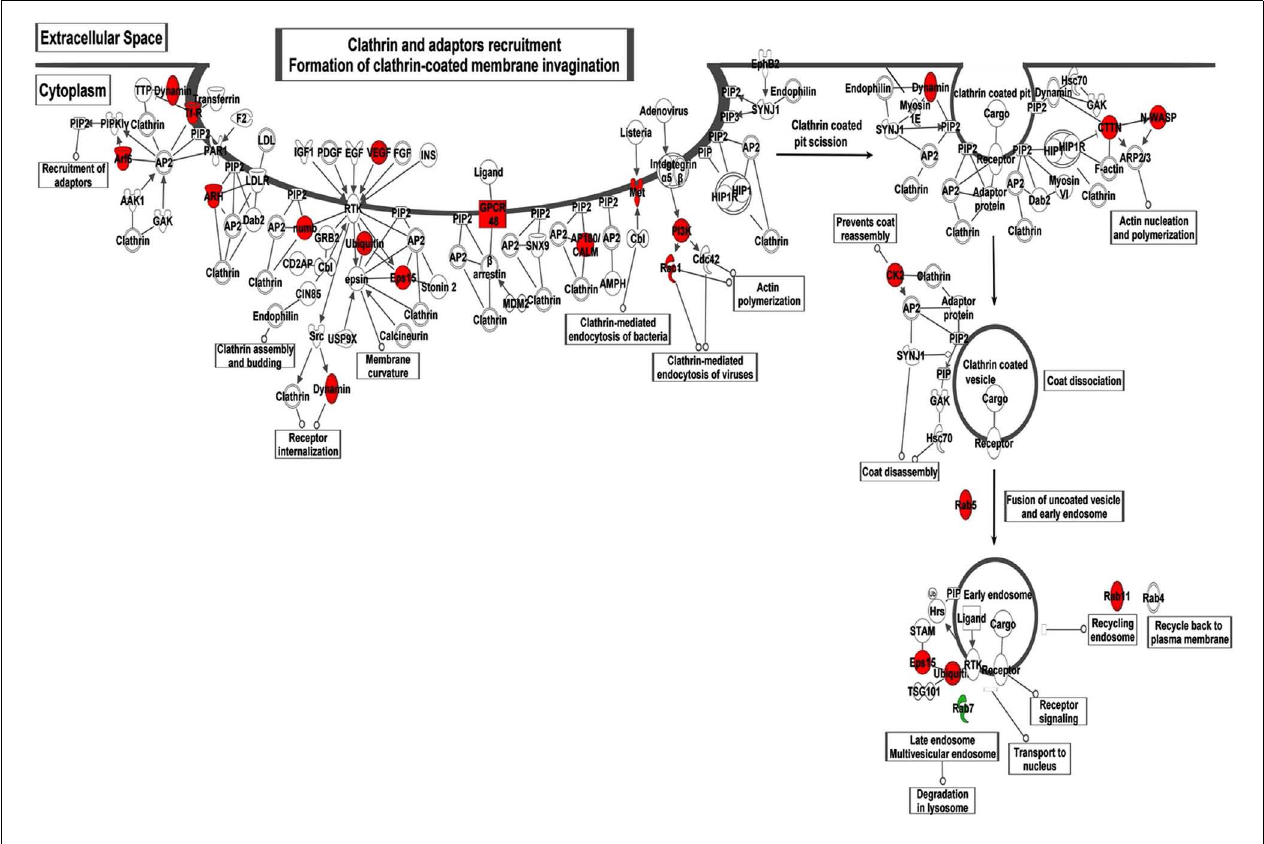
upregulated and green were down-regulated in the congenic strain compared with S.The fold changes of the corresponding Affymetrix probes are given in Table 1